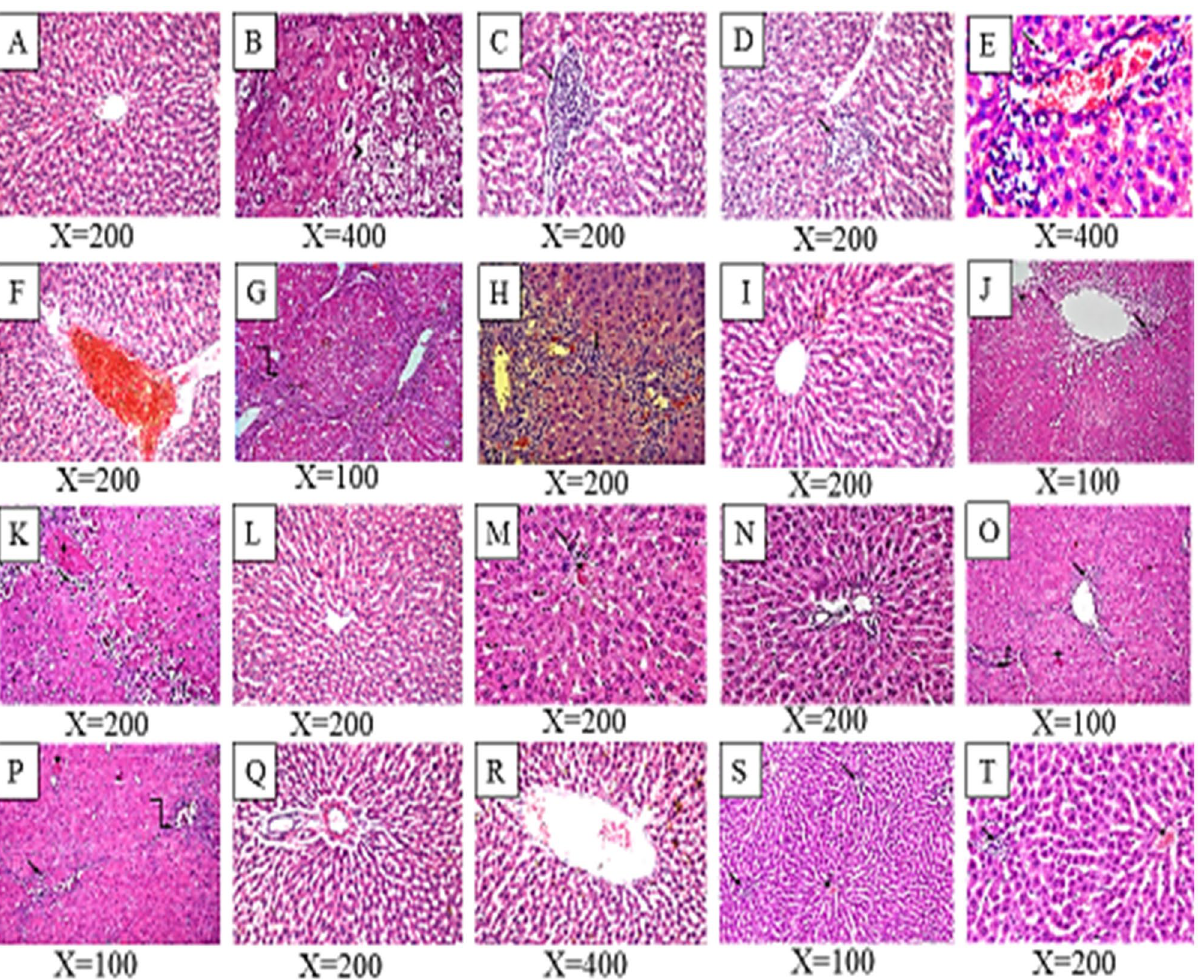
Figure 5. Histopathological findings of liver sections for different studied groups. ( A ) Section of normal control group; ( B–H ) Sections of TAA (200 mg/kg bw/i.p.) treated group; ( I ) Sections of silymarin (100